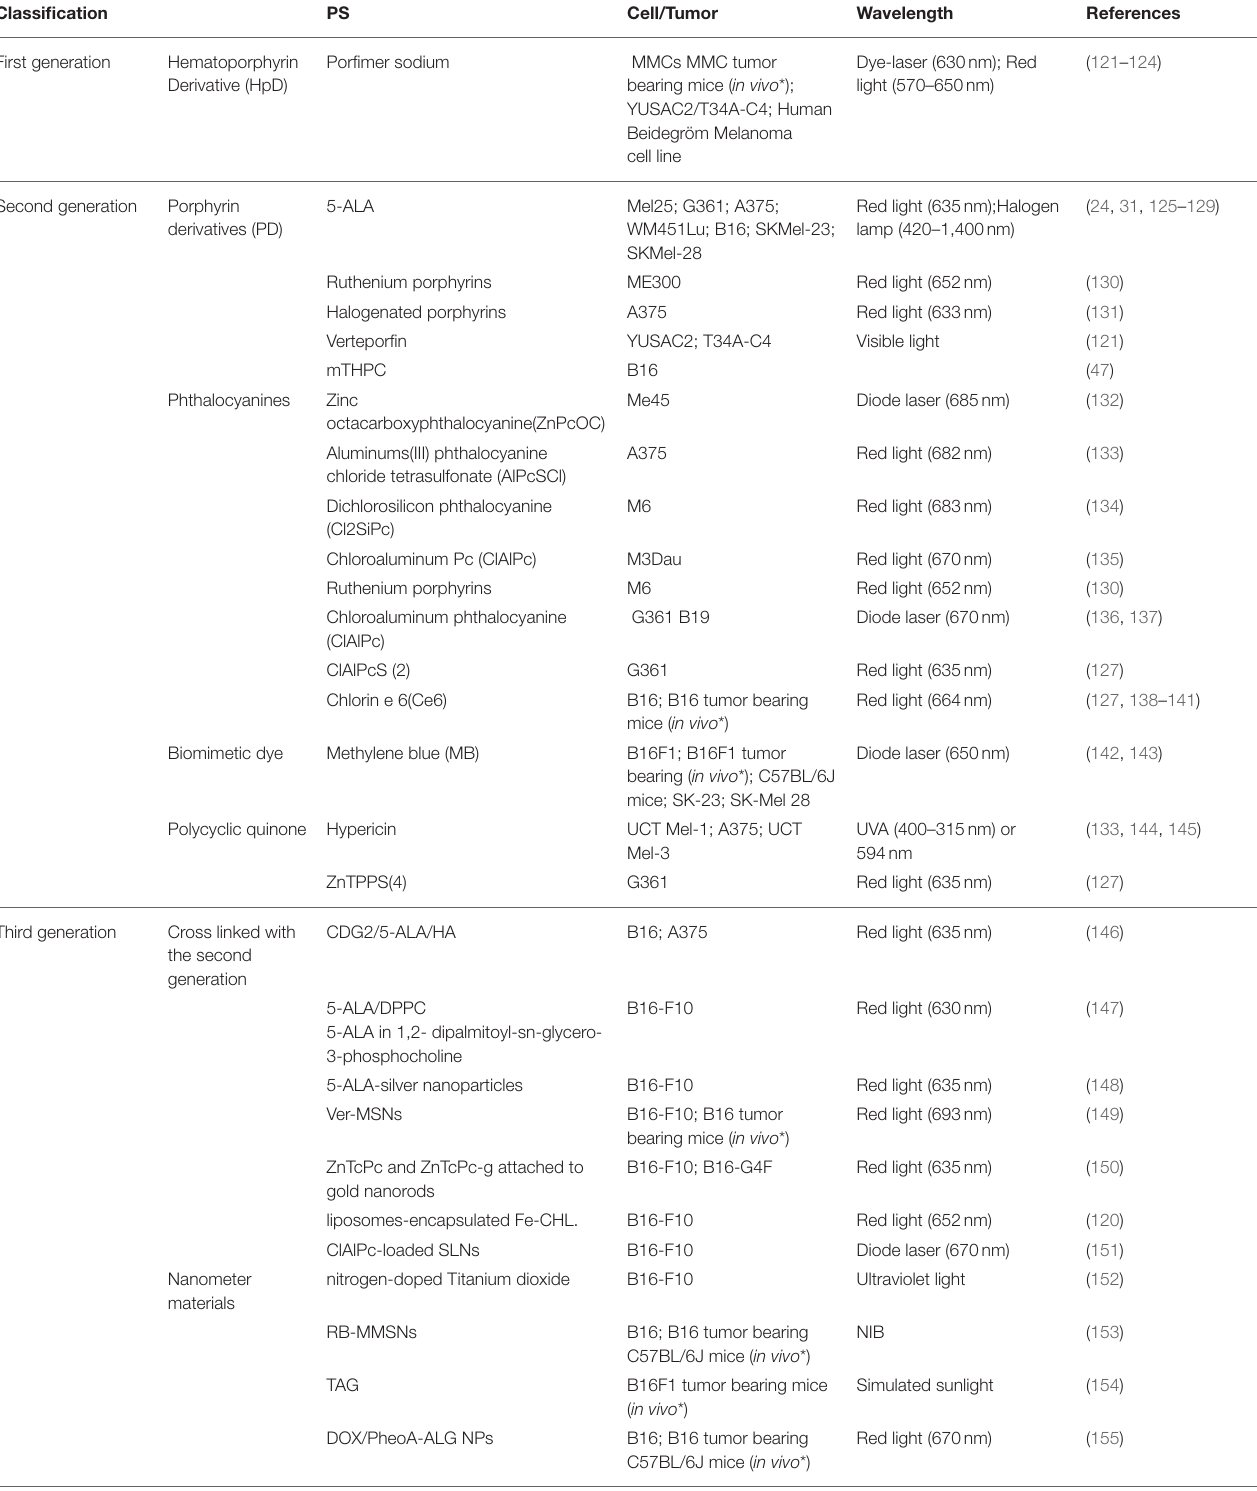
TABLE 1 | The studies of PSs used during PDT to treat melanoma.